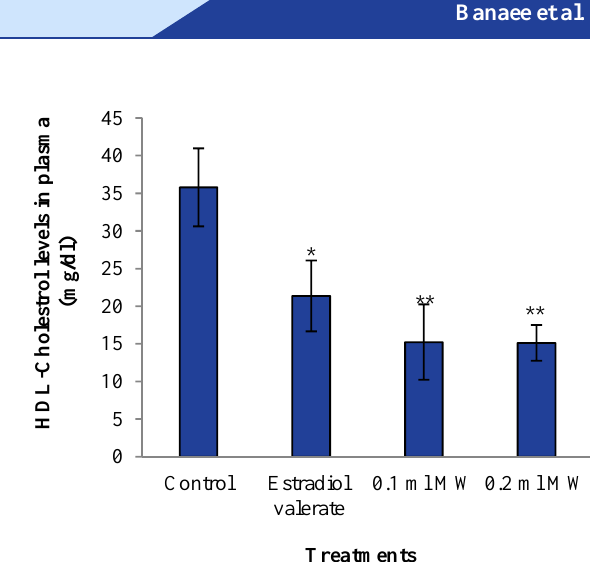
Figure 7. Plasma high-density lipoprotein cholesterol levels in immature common carp treated with estradiol valerate and different concentrations of municipal wastewater for 21 days (mean ± SD) (n = 9) Asterisk (*) indicates that the di ff erence between the experimental and control groups was significant at P < 0.05